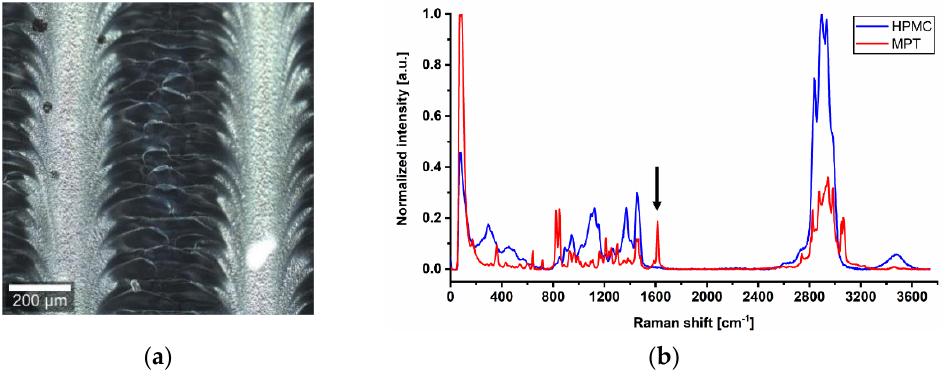
Figure 3. ( a ) Dark field image of ODF imprinted by I5. ( b ) Raman spectra of pure substances HPMC and MPT with a characteristic peak at 1615 cm −1 and 10 s exposure time, normalisation to the intensity of respective maximum peak in arbitrary unit (a.u.).